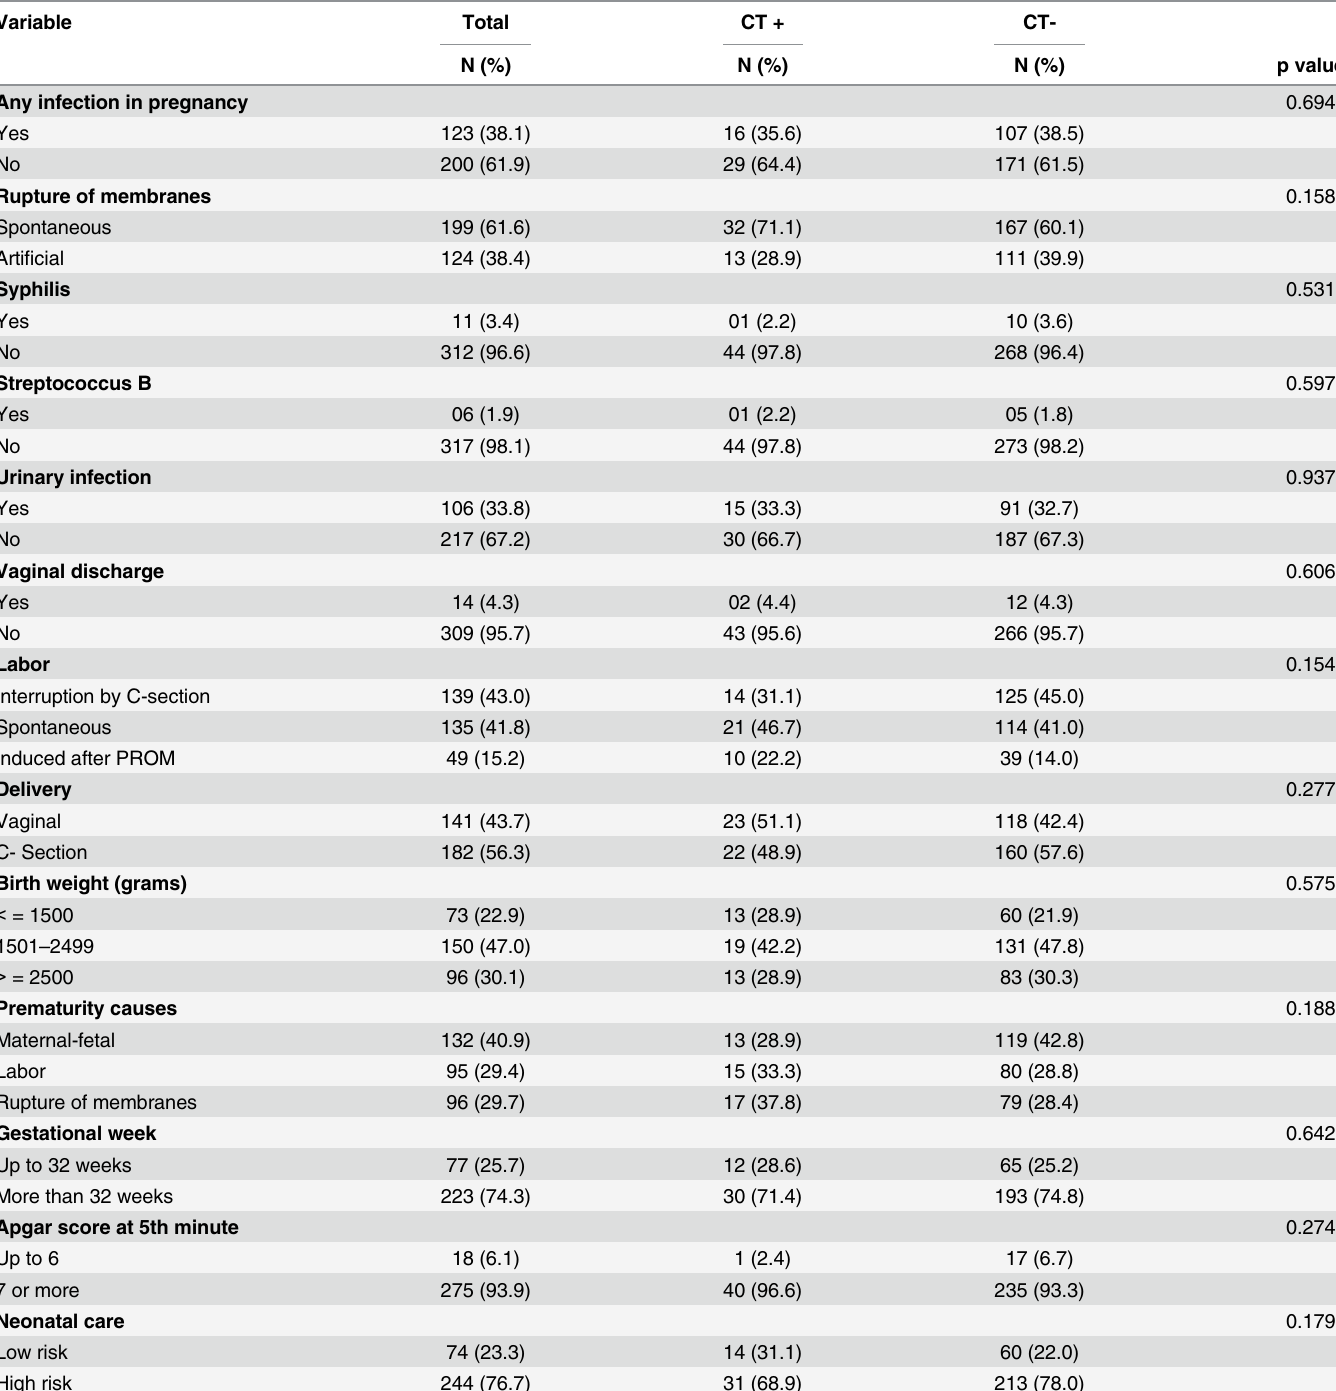
Table 2. Clinical characteristics reported by parturient women delivering preterm babies in Vitoria, 2013 by Chlamydia trachomatis (n = 323).